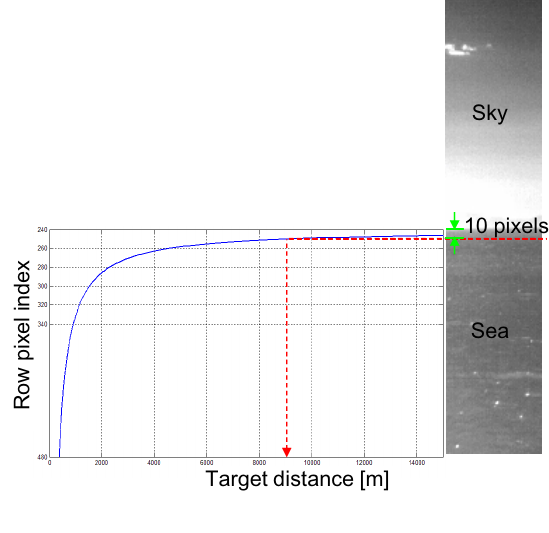
Figure 4. Analysis results for the target distance ( D ) and projected image position ( i ). ( Left ) The left graph represents the relationship between the target distance and target pixel location using Equation (3); ( Right ) while the right image is the corresponding example of the IR scene. If the sensor height is 20 m, the target height is 0 m and the minimal detection range is 6000 m, then the ship target is located 15 pixels below the horizontal